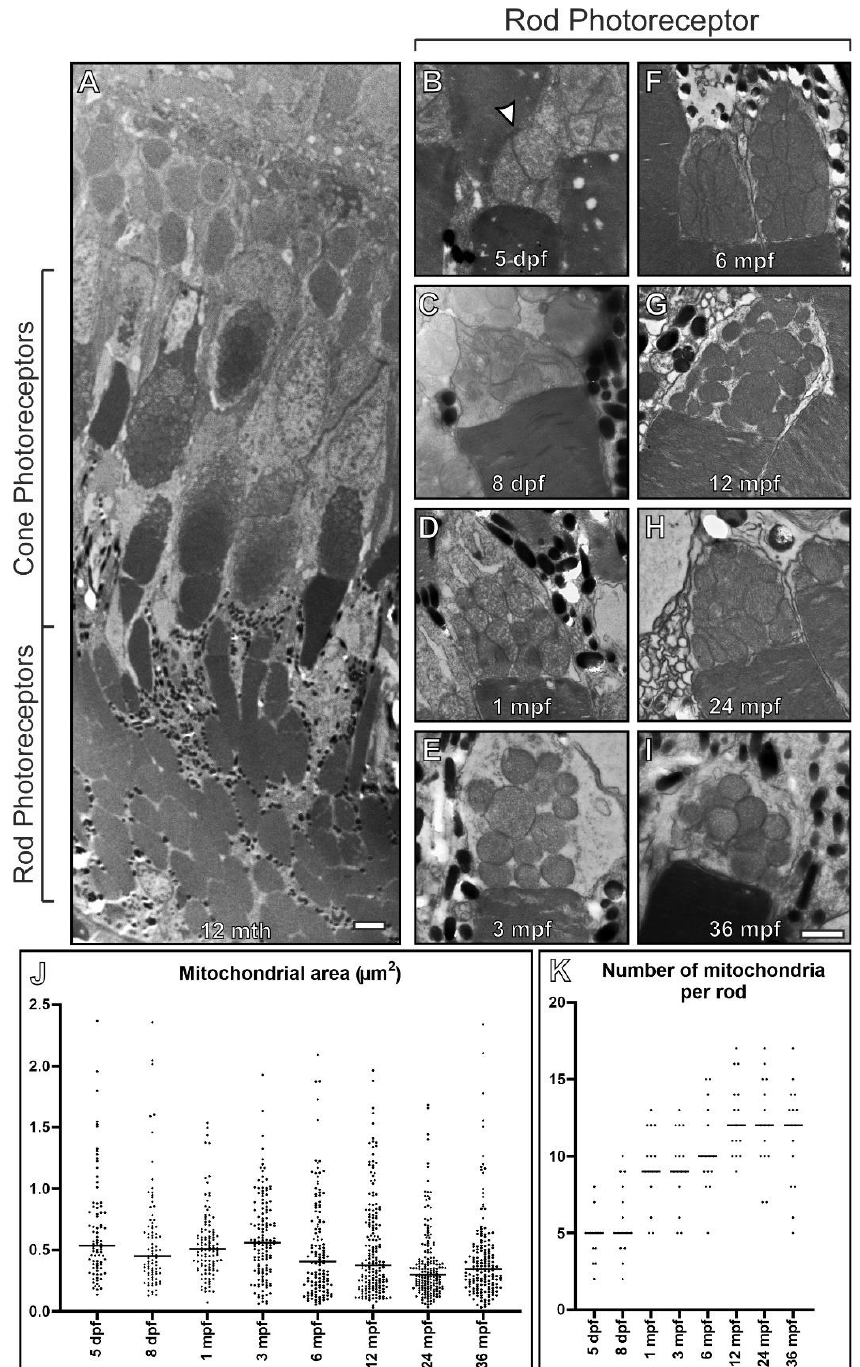
Figure 2. Rod inner segments of early embryonic zebrafish have compact mitochondria with a morphology different from other ages. ( A ) Electron microscopy image of 12 mpf retina between the RPE and ONL that includes rod and cone photoreceptor outer (POS) and inner segments. ( B – I ) Images of rod photoreceptor inner segments at 5 dpf through to 36 mpf. ( B ) At 5 dpf, the mitochondria are bundled together in a spherical like arrangement and there is a morphology change by ( C ) 8 dpf, with further changes by ( D ) 1 mpf as the mitochondria become less clumped together. There is ( J ) a reduction in rod inner segment mitochondrial size and ( K ) an increase in mitochondria number with time. Measurements were acquired from n = 3 zebrafish and included ( J ) >83 mitochondria and ( K ) n = 15 rods at each timepoint. ( J , K ) Statistical significance determined by one way-ANOVA ( J , K ) with p < 0.0001. Scale ( A ) 10 µm, ( B – I ) 1 µm.